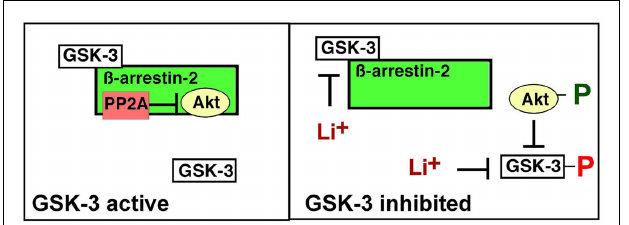
FIGURE 2 | Glycogen synthase kinase-3 regulation of the β -arrestin-2 scaffold. GSK-3 binds to and stabilizes the β -arrestin-2/PP2A/Akt complex, promoting PP2A-mediated dephosphorylation, and inactivation of Akt, which in turn maintains GSK-3 in an active state. Direct inhibition of GSK-3 disrupts the β -arrestin-2/PP2A/Akt interaction allowing activation of Akt, which then phosphorylates, and inhibits GSK-3.